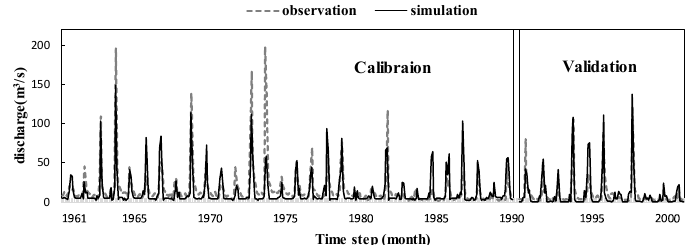
Figure 3. Monthly observed and simulated discharge at Zhangjiafen station along Bai River.